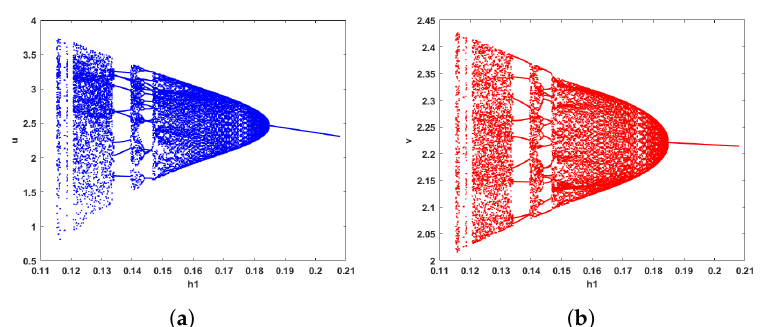
Figure 7. Bifurcation diagram of system (2) with h 1 ∈ [0.11, 0.21], r 1 = 1.15, r 2 = 0.8, a = 0.4, b = 0.2, c = 2, d = 0.1, k = 5, δ = 4.88, h 2 = 0, the initial value is ( u , v ) = (4, 2). ( a ) Bifurcation diagram for u . ( b ) Bifurcation diagram for v